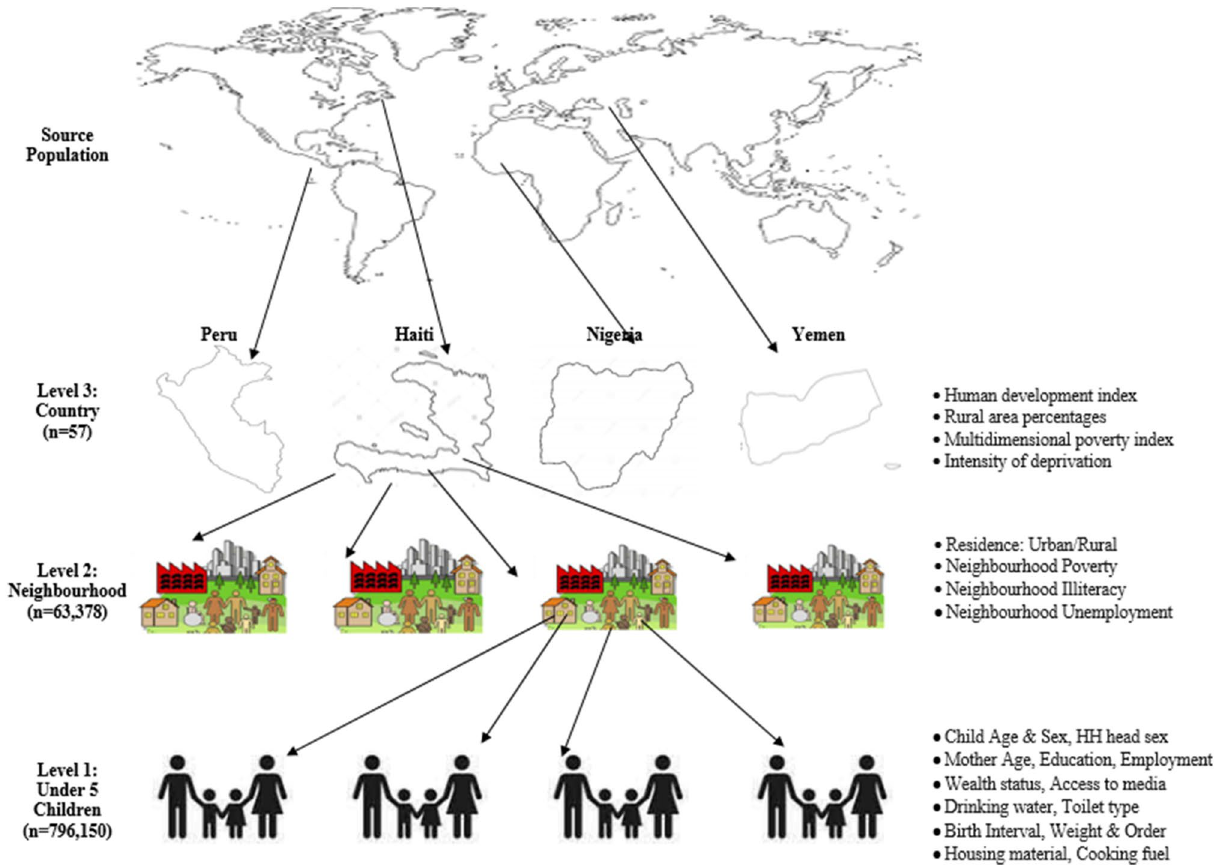
Figure 1. The hierarchical structure of the source data (Authors’ drawings using World Map 39